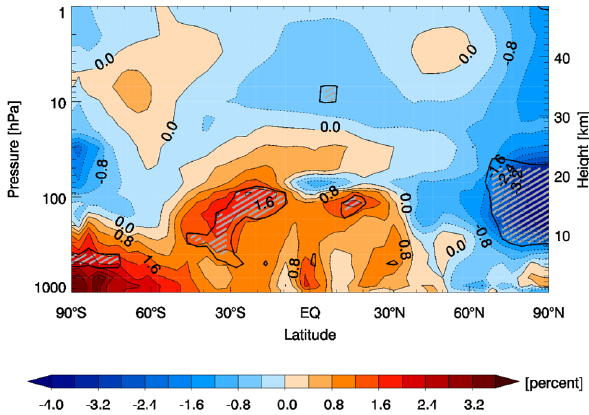
Annual mean effect of GCRs on zonal mean ozone, ([O 3 ] GCR -[O 3 ] control ) /[O 3 ] control , given in percent. Results are av- eraged from 1978–2002 (after allowing for a 2-year model spin-up) with appropriate accounting for solar minimum and maximum pe- riods. Hatched areas (enclosed by thick solid contours) indicate changes with at least 95% statistical